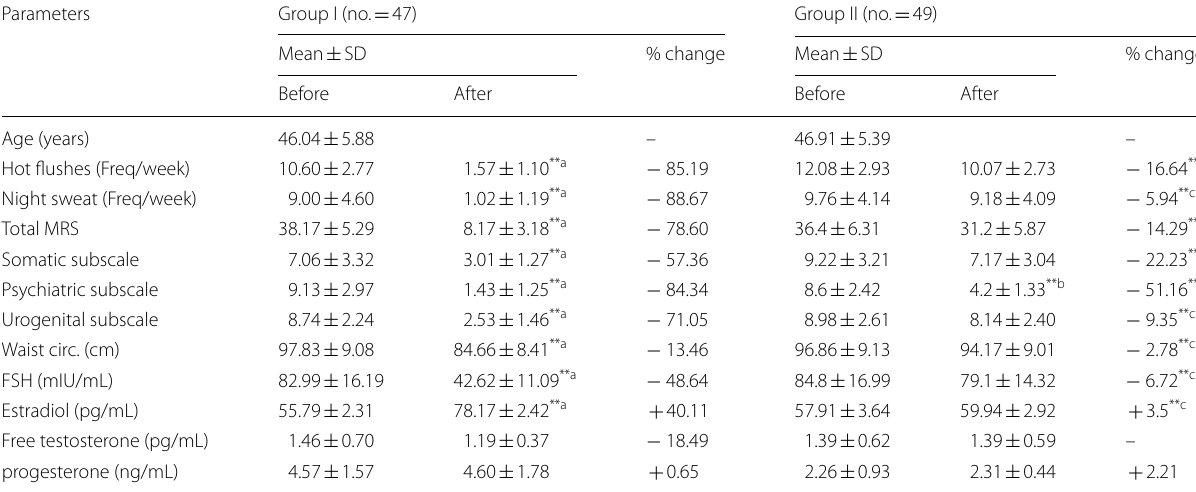
SD of age, menopausal symptoms and female sex hormones among studied groups before and after dietary ±